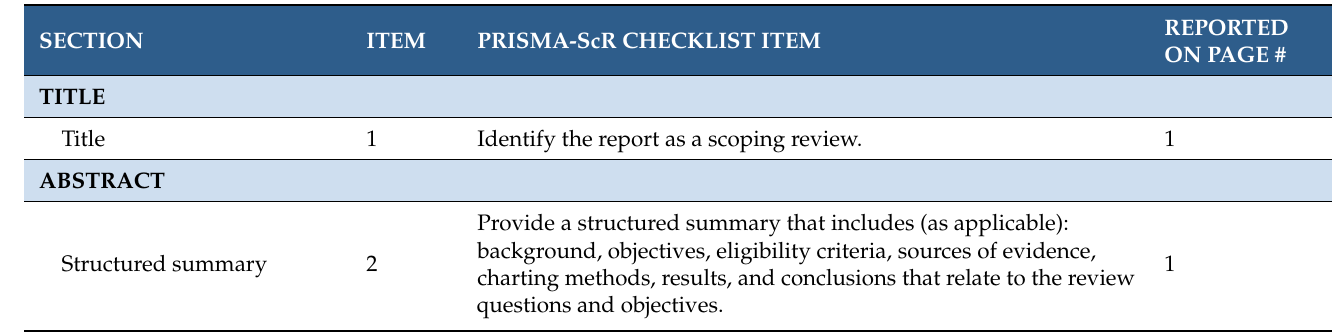
Table A1. Preferred Reporting Items for Systematic Reviews and Meta-Analyses Extension